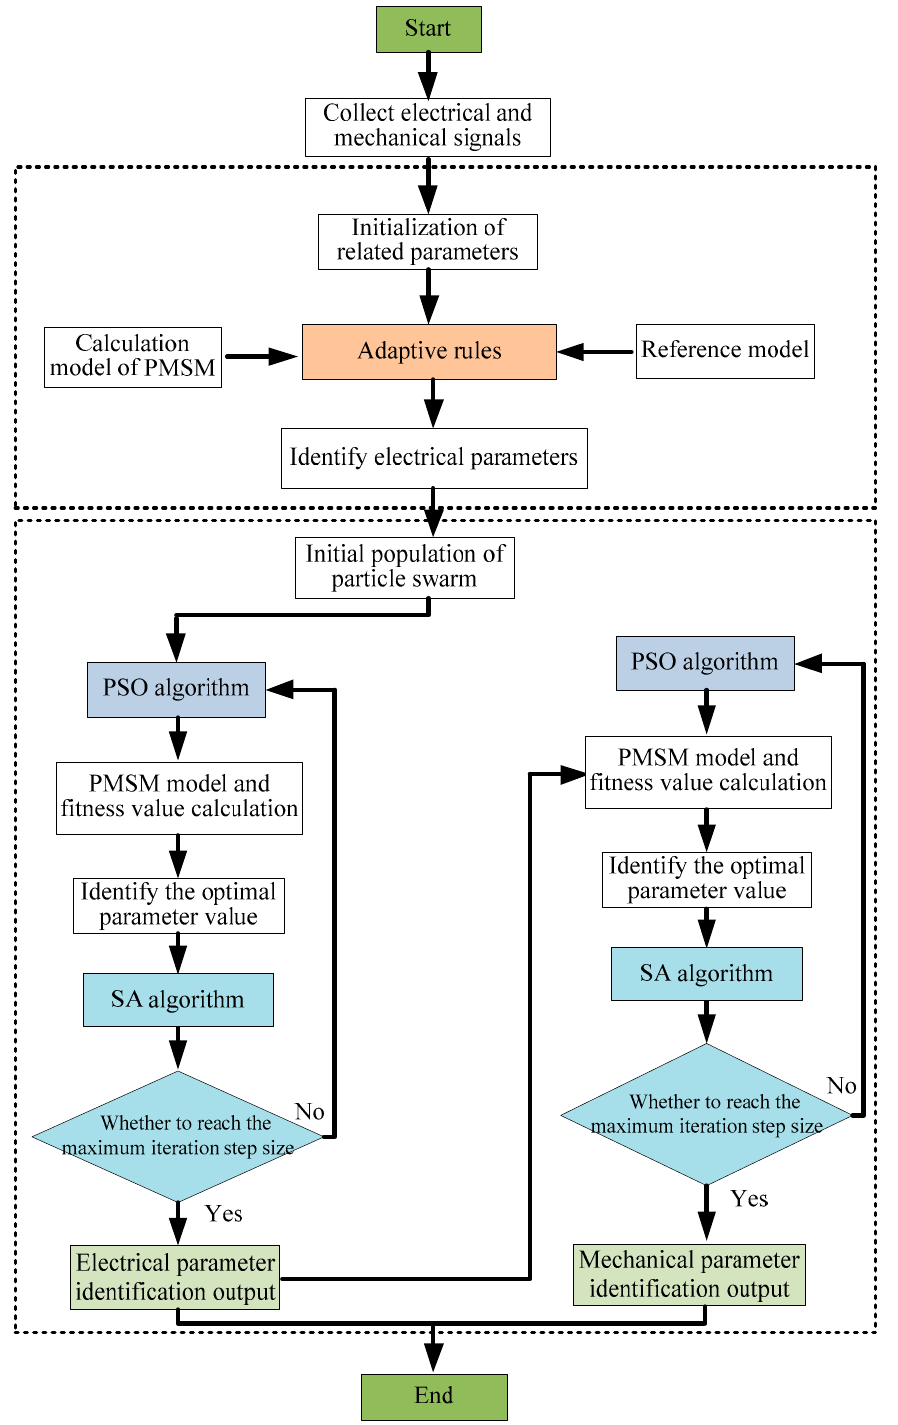
Figure 3. Flow chart of PMSM multiparameter identification based on MRAS-SAPSO.